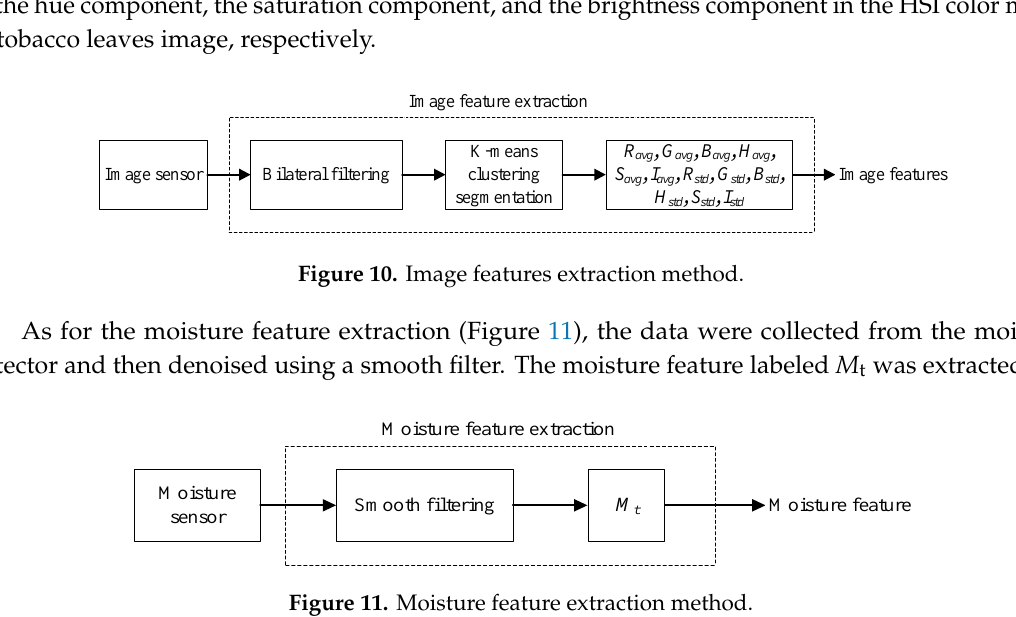
Figure 11. Moisture feature extraction method.